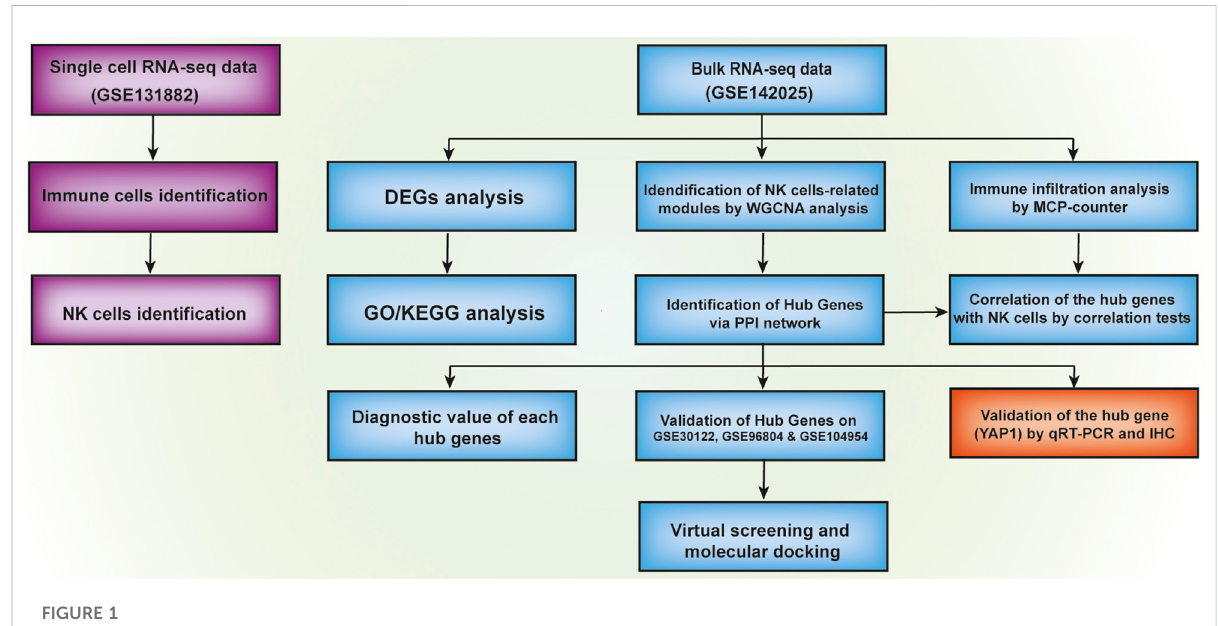
FIGURE 1 Flowchart of the analysis used in this